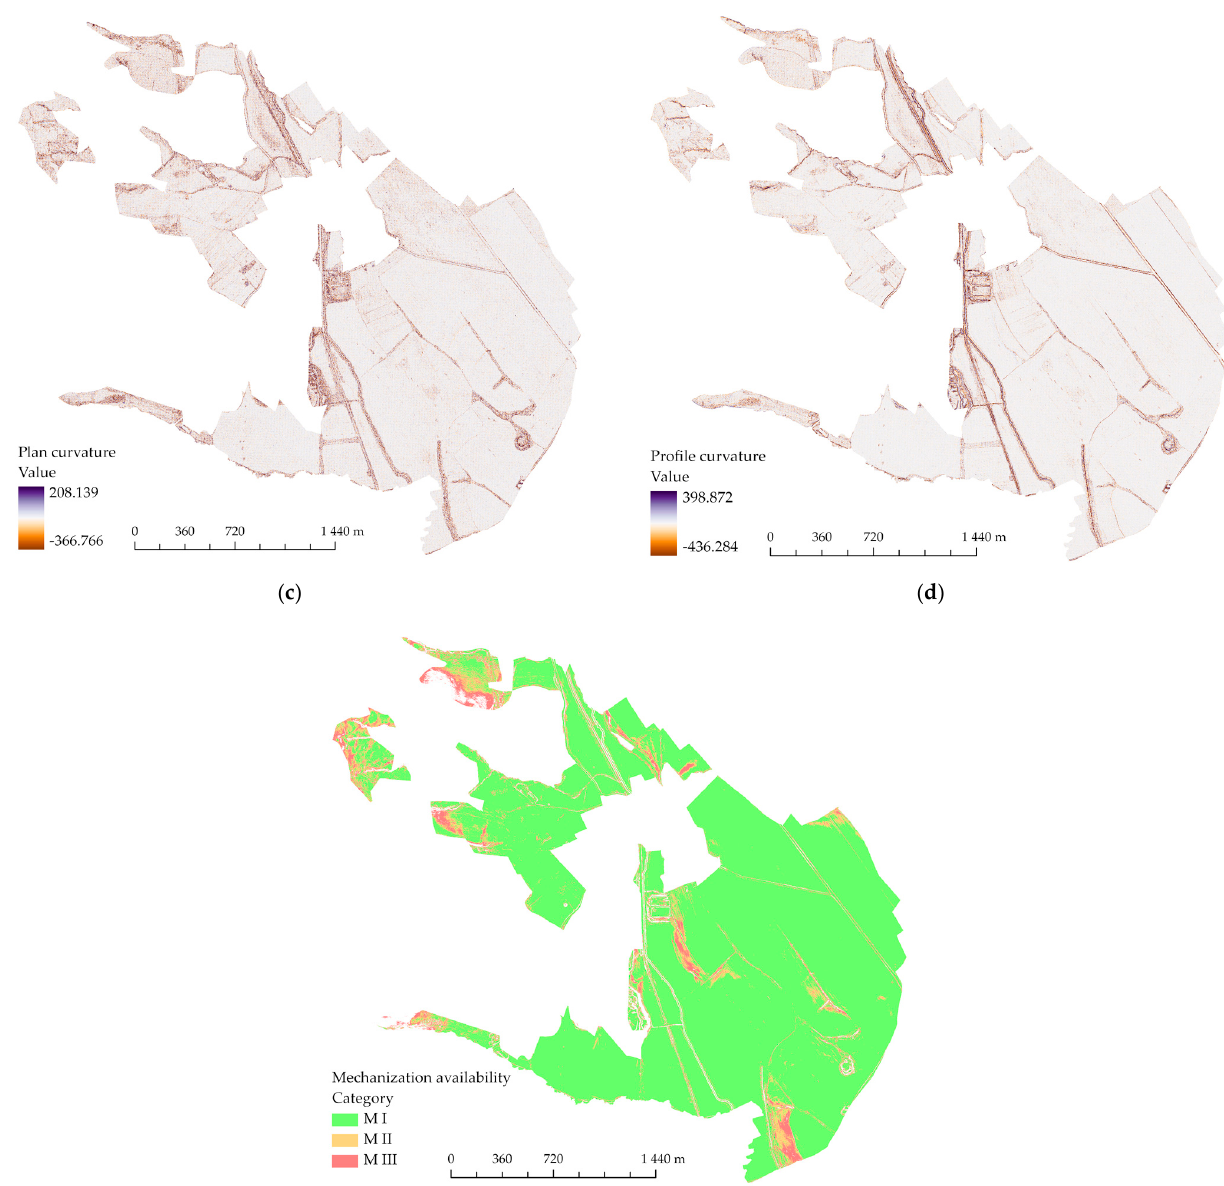
Figure 11. Purpose maps in land consolidation ( a ) terrain insolation; ( b ) Slope length; ( c ) Plan curvature; ( d ) Profile curvature; ( e ) Mechanization availability.